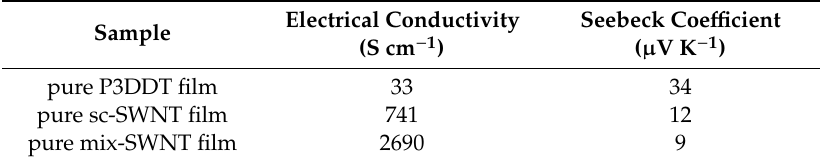
Table 1. Electrical conductivity and Seebeck coefficient of pure P3DDT film, sc-SWNT film and mix- SWNT film.